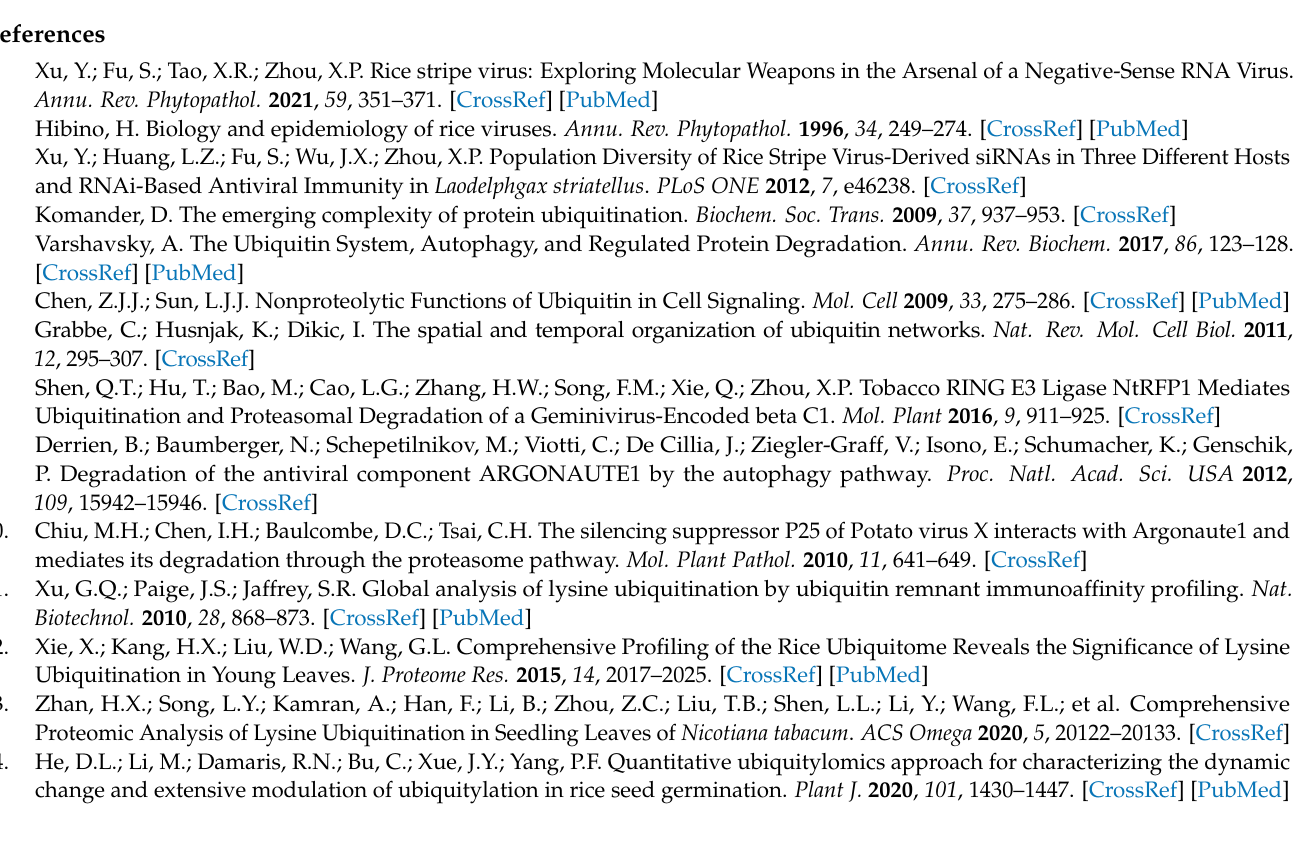
qPCR; Table S2: Detailed information of identified Kub sites; Table S3: Detailed information of the ubiquitination